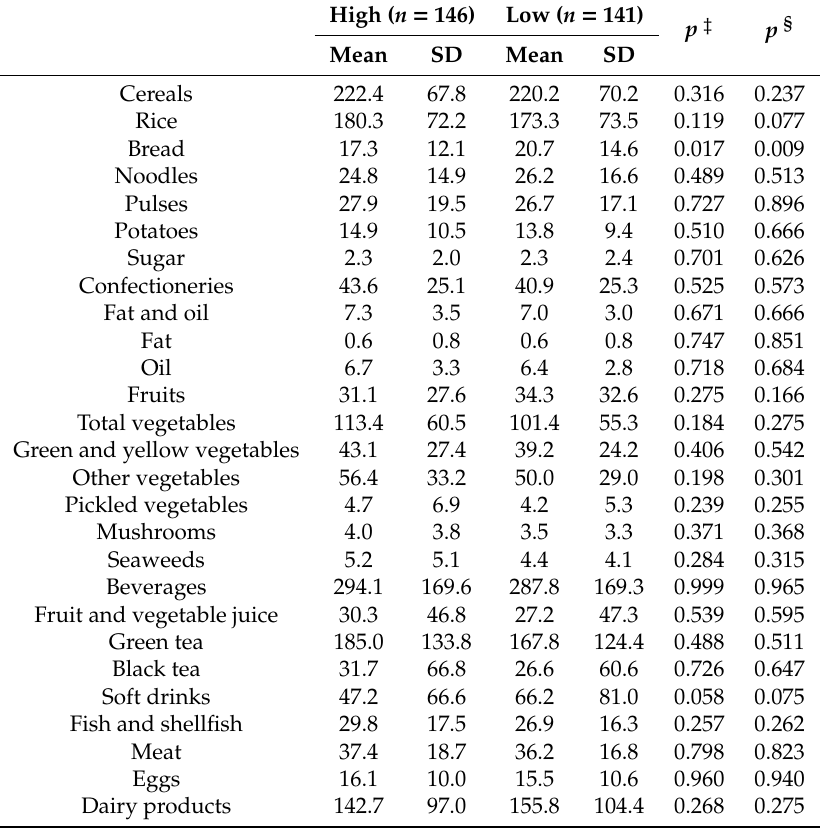
Table 3. Habitual daily food group intakes among 287 junior high school students categorized into high and low groups by mother’s nutrition knowledge level (g / 1000